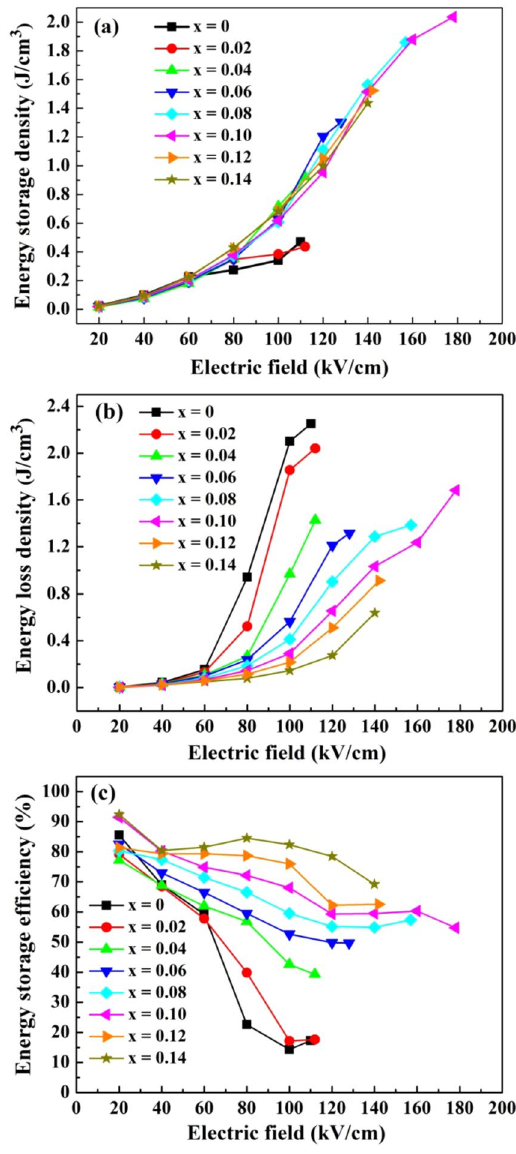
Figure 8. Calculated energy storage density, energy loss density and energy storage efficiency as a function of electric field for the (1-x)LLBNTZ-xNBN ceramics at room